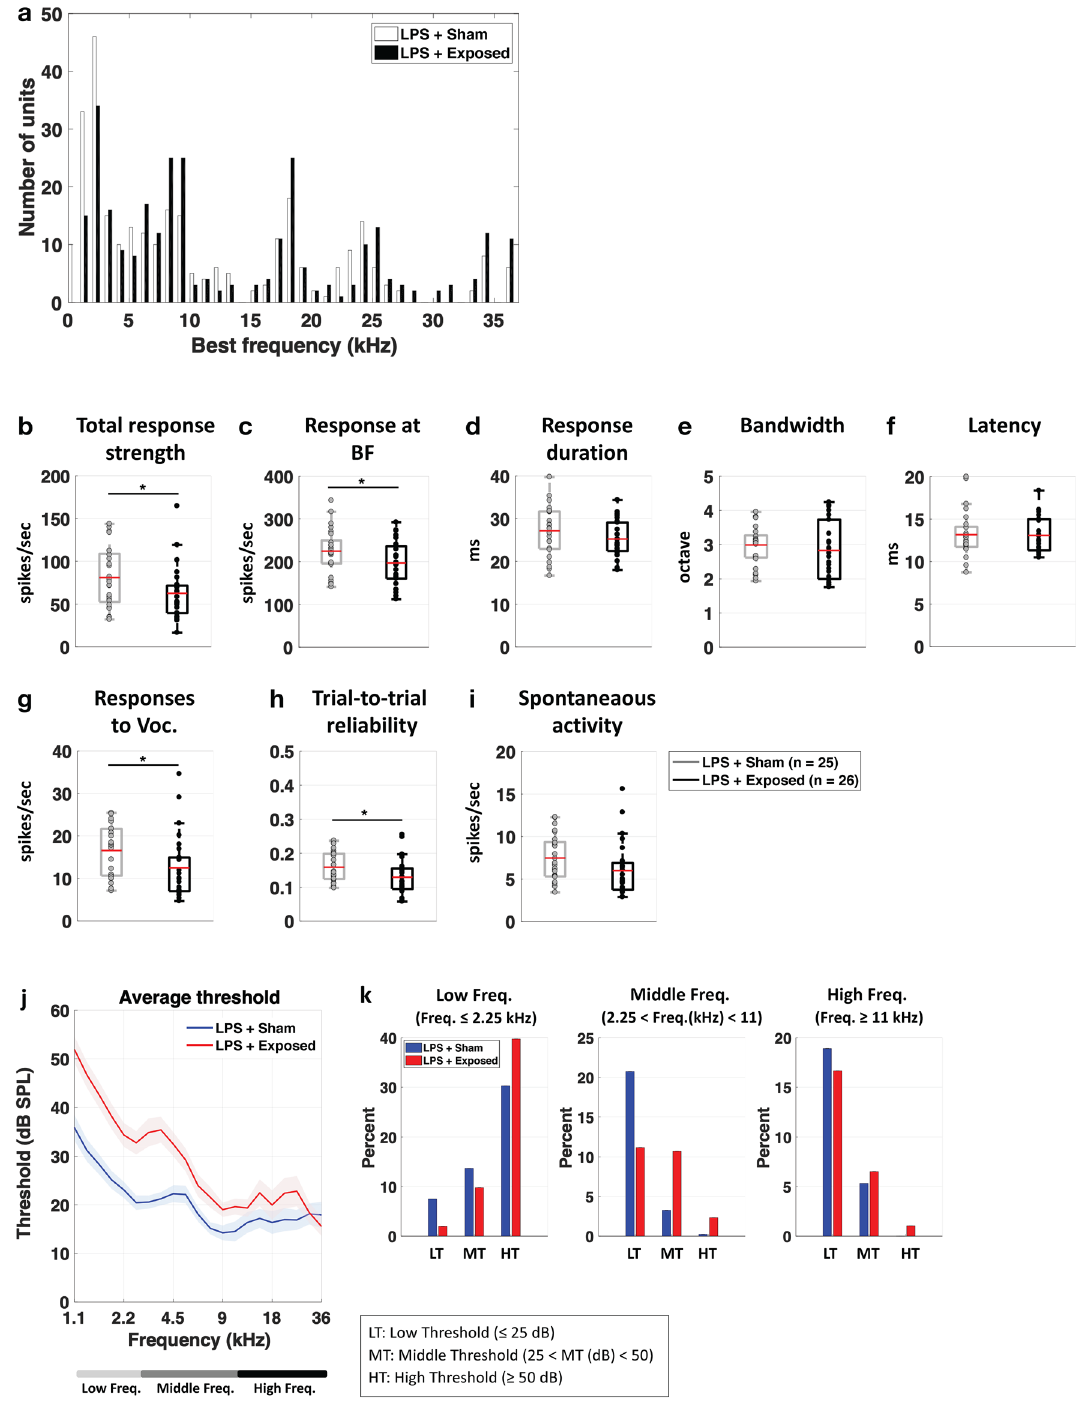
Figure 4. Effects of LTE exposure on parameters quantified from cortical responses in the LPS-treated animals. ( a ) BF distributions of the cortical neurons for the LPS-treated animals exposed to LTE (in black) and Sham- exposed to LTE (in white). The two distributions did not differ. ( b – f ) Effects of LTE exposure on the parameters quantifying the spectro-temporal receptive fields (STRF). The response strength was significantly decreased (* p < 0.05, unpaired t test) both on the entire STRF (total response strength) and at the best frequency ( b , c ). The response duration, the response bandwidth and the bandwidth were unchanged ( d – f ). Both the strength and the temporal reliability of the responses to vocalizations were decreased ( g , h ). Spontaneous activity was not significantly decreased ( i ). (* p < 0.05, unpaired t-tests). ( j , k ) Effects of LTE exposure on the cortical thresholds. The average thresholds were significantly higher in LTE-exposed rats compared to Sham-exposed rats. This effect was more pronounced in the low and middle